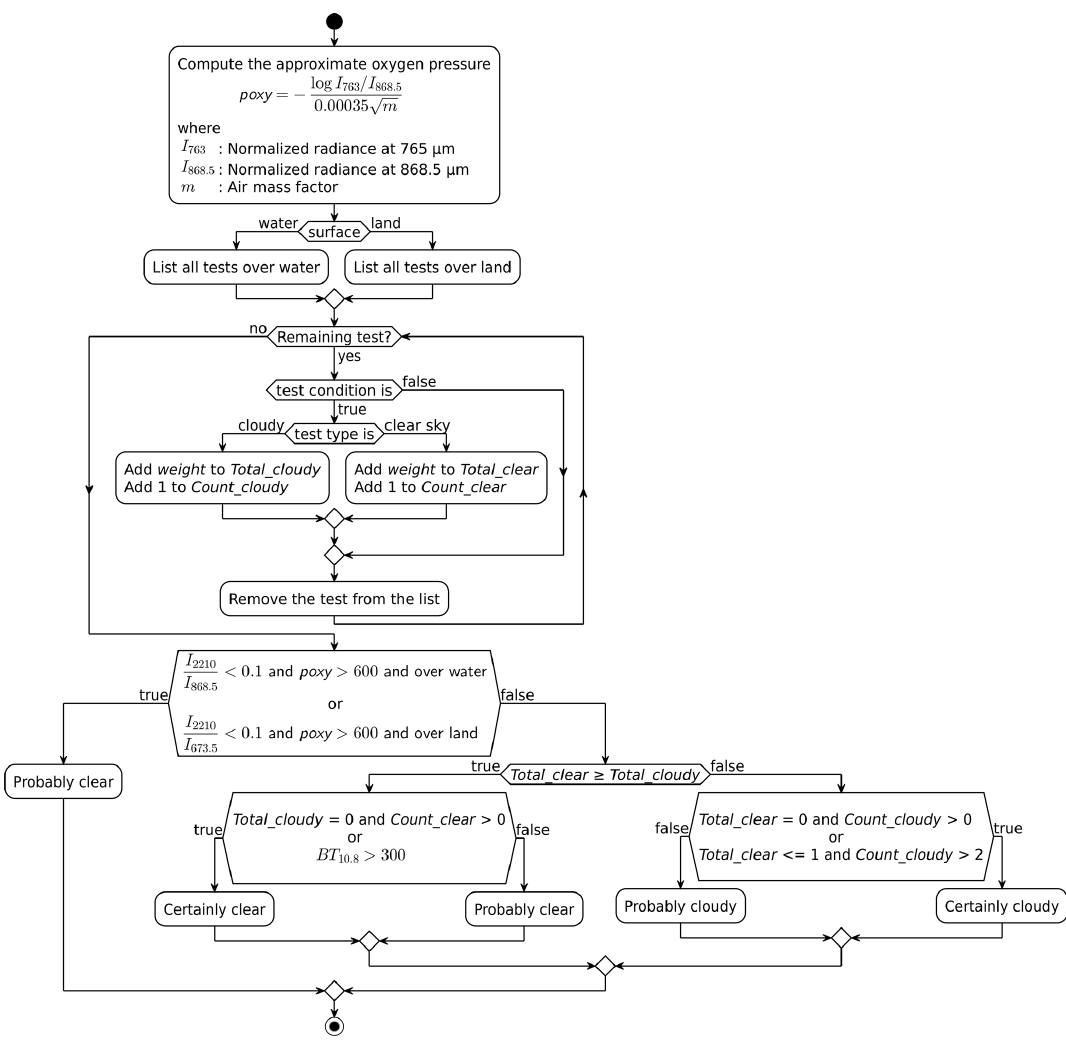
Figure 2. The activity diagram (flowchart) of the cloud flag algorithm. Table 4. Tests for the cloud detection algorithm over water. I XXX indicates the normalized radiance at wavelength XXX nm, BT XX indicates the brightness temperature at XX µm, and σ XXX the standard deviation of I XXX in the concentric box of 3 × 3